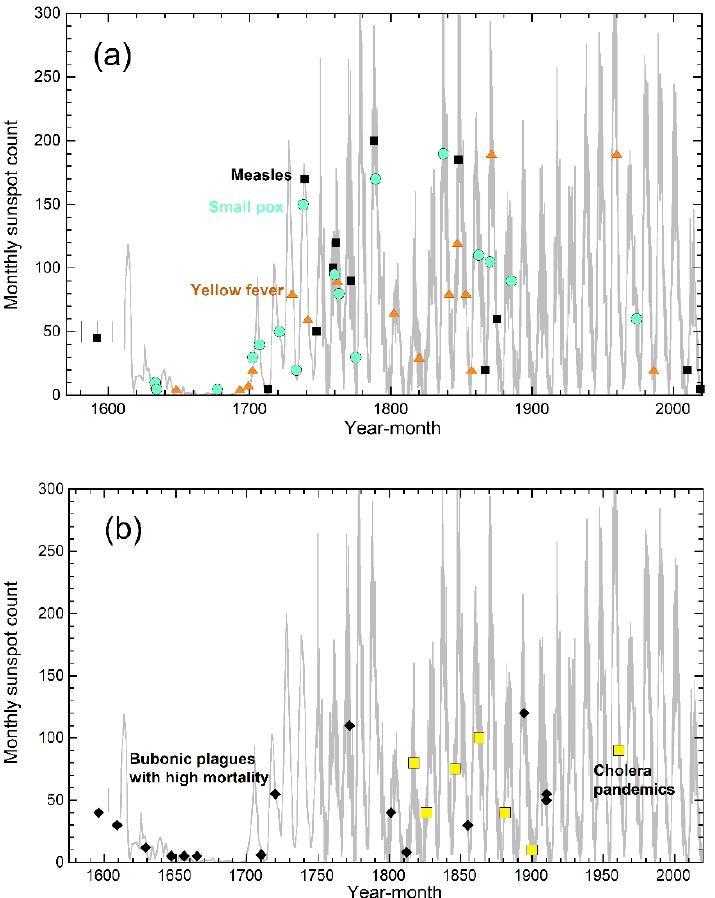
Figure 3. Graphs showing that the onset of various other epidemics and pandemics since the first influenza pandemic of 1580 do not correlate with sunspot number. Data from [67,70]: ( a ) Diseases carried by viruses. Small measles epidemics are included. Historical measles virus epidemics are absent in the Maunder minimum, and somewhat correlate with sunspot maxima, but the scatter is large. Both measles (square symbols) and smallpox (circles) are passed by close contact, whereas yellow fever (triangles) is carried by insects; ( b ) Bacterial diseases. Only major bubonic plagues are shown (diamonds), defined by deaths exceeding 50,000 long ago and 100,000 recently. Cholera (large squares) is water-borne whereas bubonic plague has been connected with fleas.